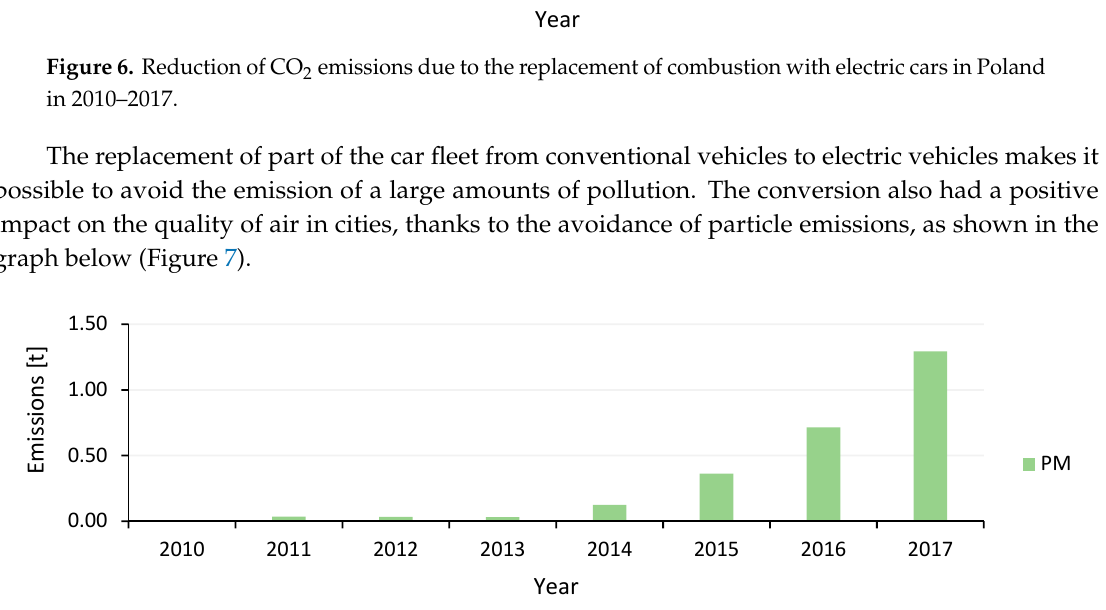
Figure 7. Reduction of PM emissions thanks to the replacement of electric cars in Poland in 2010–2017.